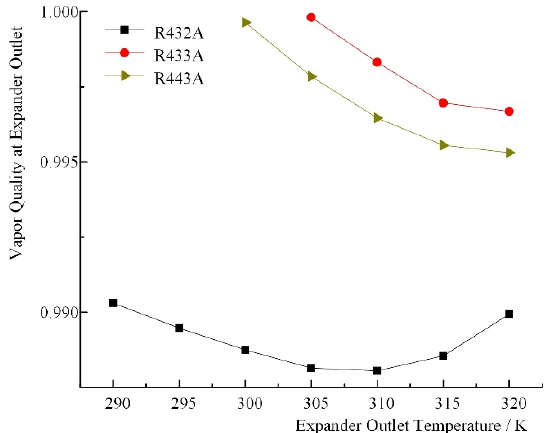
Figure 11. Relation between vapor quality at the expander outlet and the expander outlet temperature.